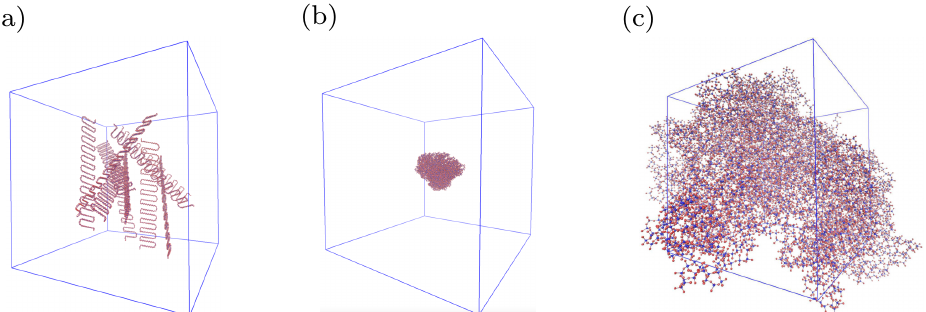
Figure 2. ( a ) Randomly distributed silicone chains in a periodic supercell; ( b ) the silicone chains after crosslinking procedure; ( c ) model of silicone